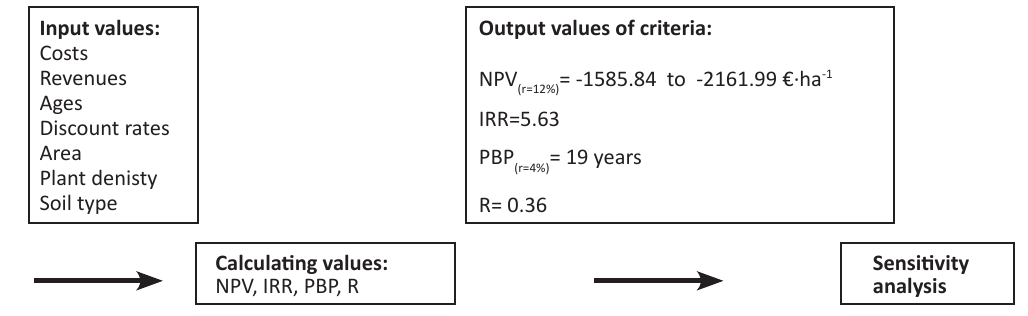
FiGURe 1. Calculation of individual criteria using input and output values.